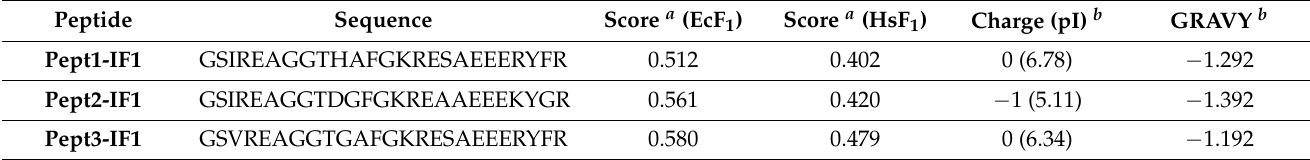
a The domain ‘smart00382’ was mapped on the β subunits of EcF 1 and HsF 1 using the NCBI tool CD-Search [56] to identify conserved domains. The extracted fragments of the subunits were used to compute the interaction scores with the peptides. b Values calculated with ProtParam [57]. scores with the peptides. b Values calculated with ProtParam [57].